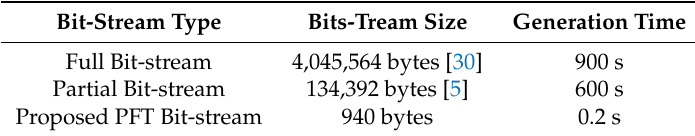
Table 6. Generation Time Comparison for XC7020 Bit-stream.